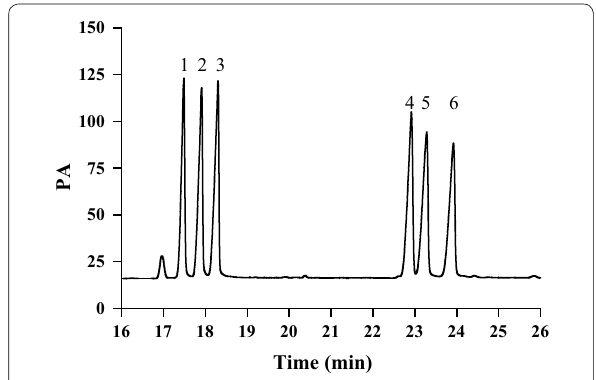
Fig. 3 Gas chromatograms of standard monosaccharide mixture solution (1) l -rhamnose (Rha) (2) l -arabinose (Ara) (3) d -xylose (Xyl) (4) d -mannose (Man) (5) d -glucose (Glu) (6) d -galactose